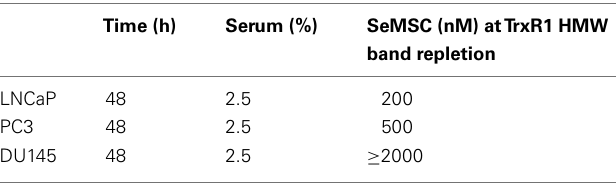
Table 3 | SeMSC concentrations at whichTrxR1 expression plateaus as determined by western